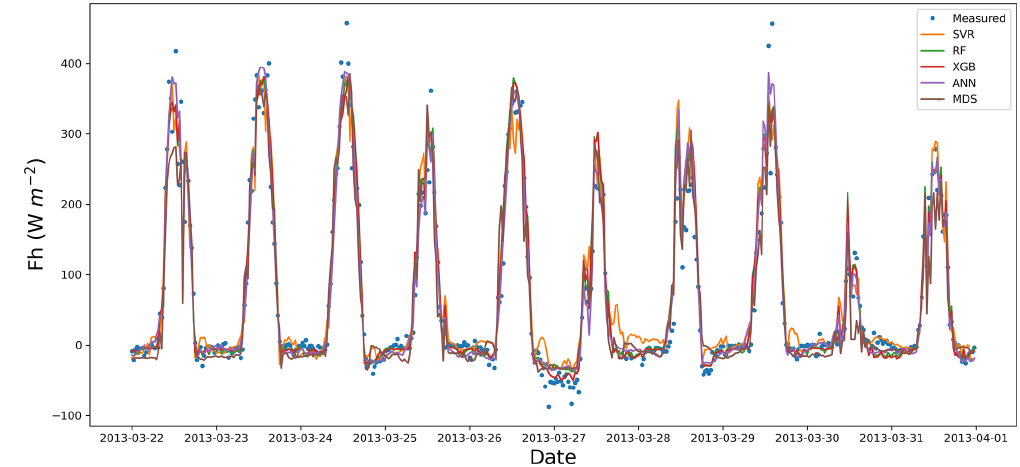
Figure 4. Measured vs. estimated values of F h for Calperum based on a 10d gap window (22–31 March